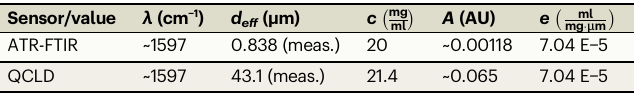
Table 2 | Experimental fi gures-of-merit for ATR-FTIR & QCLD- sensor